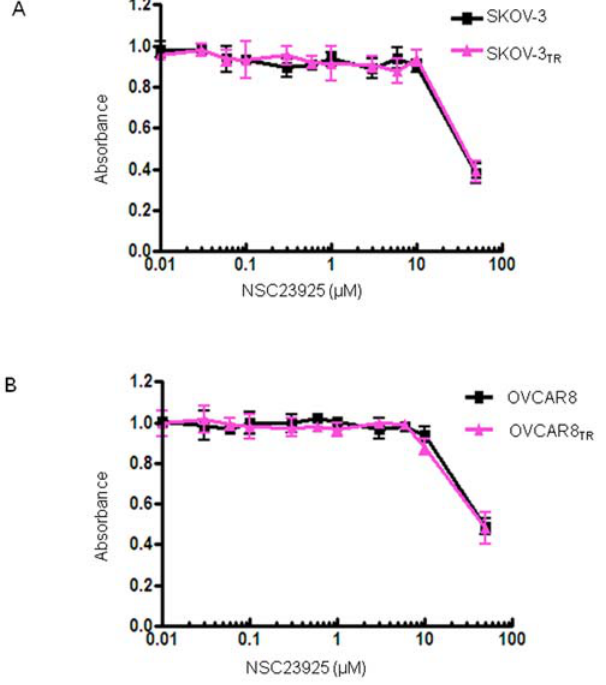
Figure 4. Nonspecific toxicity of NSC23925 on SKOV3 vs SKOV- 3 TR and OVCAR8 vs OVCAR8 TR . Cells were treated with the NSC23925 in RPMI1640 complete media at the indicated concentrations. The relative sensitivity of each line to NSC23925 was determined by MTT assay. A : Nonspecific toxicity of NSC23925 on SKOV3 vs SKOV-3 TR and OVCAR8 vs OVCAR8 TR . B : Nonspecific toxicity of NSC23925 on OVCAR8 vs OVCAR8 TR .